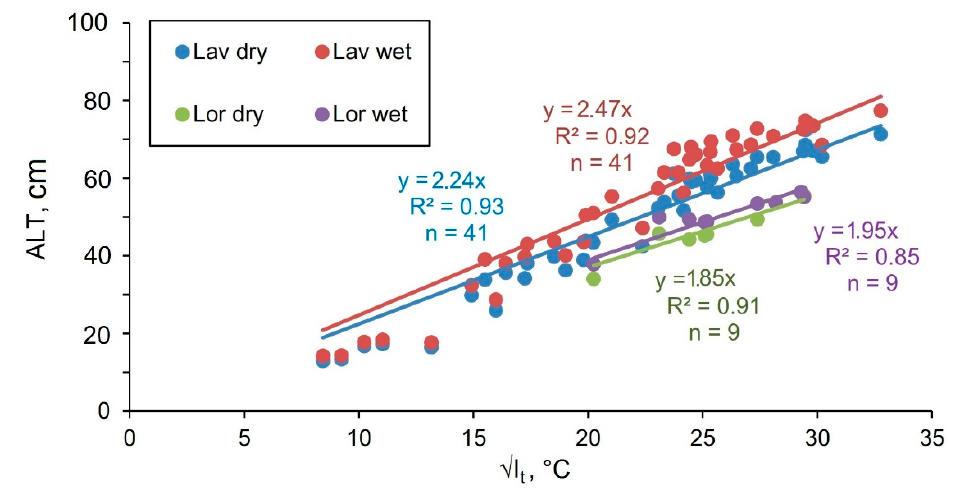
Figure 6. Interrelation of measured active layer thickness and square root of thawing index on the CALM sites of Eastern Chukotka.